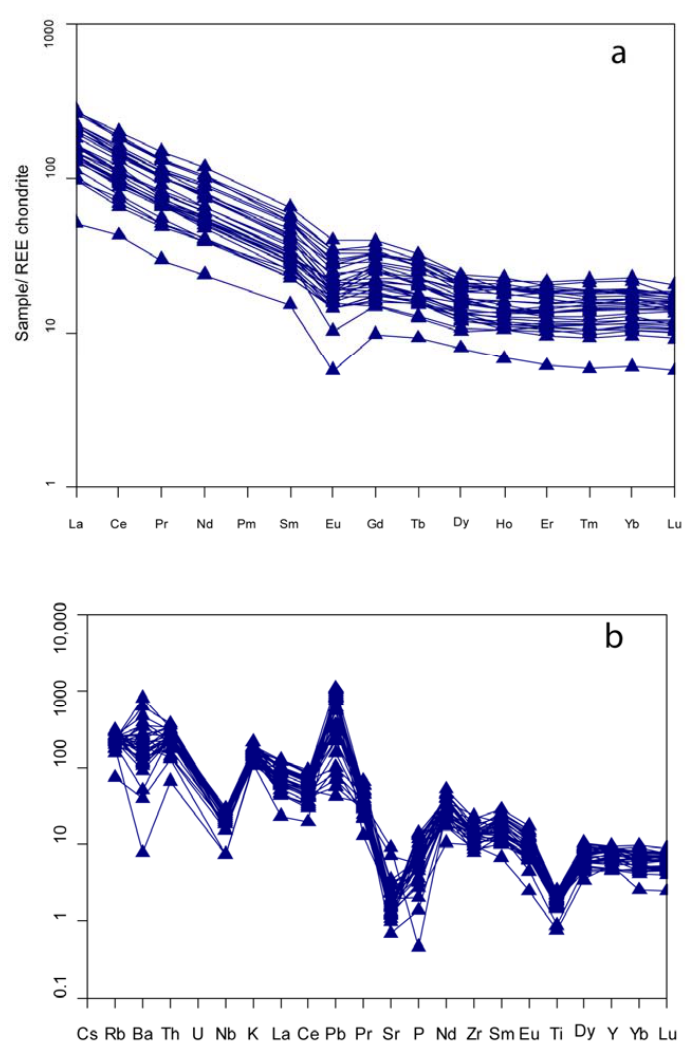
Figure 13. ( a ) Chondrite-normalized rare earth element (REE) plots [84]; and ( b ) Primitive mantle normalized spider plot of trace element [86] of the felsic volcanic rocks from the study area. (Data source: Table